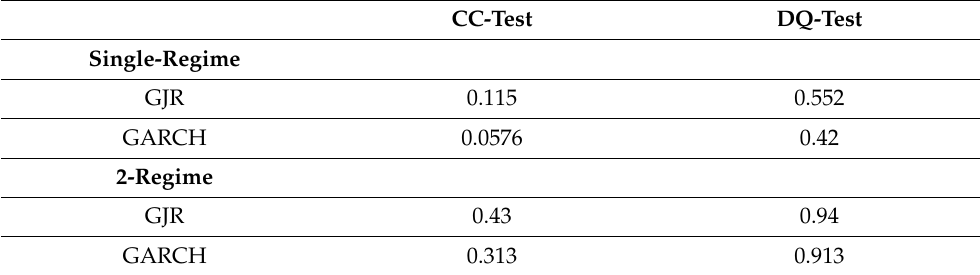
Table 10. p -values for the CC test and DQ test for the one-day ahead 5%